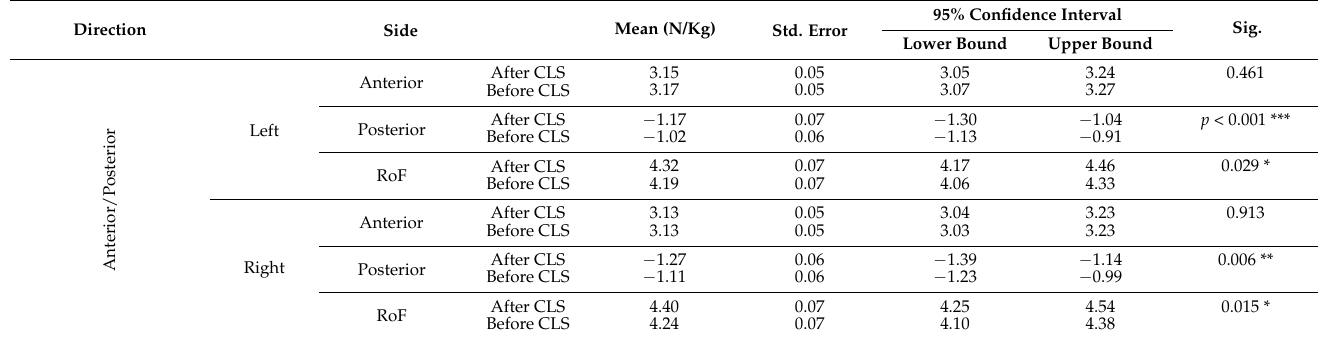
Table 6. Hip Joint Force in Anterior/Posterior, Medial/Lateral, and Tension/Compression